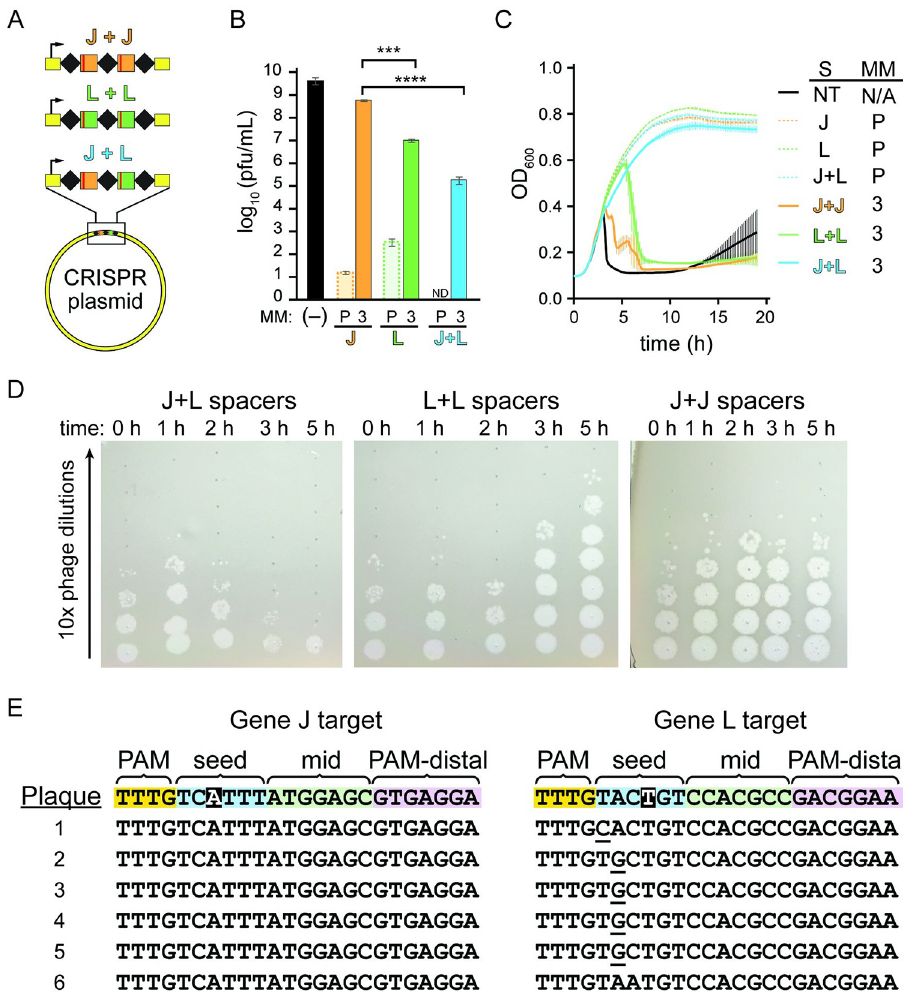
Fig 6. Multiple mismatched crRNAs provide more protection than individual mismatched crRNAs. (A) Schematic of experiment in which 2 crRNAs bearing mismatches at position 3 are expressed from a CRISPR plasmid. The CRISPRs either have 2 identical spacers targeting gene J (J+J) or gene L (L+L), or have 2 different spacers targeting gene J and L (J+L). (B) Number of plaques formed on lawns of bacteria expressing multiple mismatched crRNAs. Plaque assays were performed using bacteria containing a plasmid expressing FnCas12a along with different crRNA expression plasmids. Plasmid expressed either the perfect crRNA (P) or the position 3 mismatched crRNA (3). For the perfect crRNAs, plasmids expressed either 1 (gene J or gene L alone) or 2 (J+L) spacers. For the position 3 mismatched crRNAs, each crRNA expression plasmid contains 2 spacers: both targeting gene J both targeting gene L and 1 spacer targeting each of gene J and gene L (J+L). (-) indicates a negative control in which no crRNA was expressed. Plaque forming units (pfu) was calculated using the number of plaques on each plate and the volume of phage lysate added. The average of multiple replicates ( n = 2 to 4) is plotted with error bars representing standard deviation. Unpaired, two-tailed t tests were used to determine the statistical significance of each of the single spacer constructs compared to the double spacer construct, *** P � 0.001, **** P � 0.0001. See S2 Data for quantified data. (C) Growth curves using the same bacterial strains described in (A). Phage was added when the cells reached mid log phase at approximately 2 h after inoculation. The average of 3 replicates is plotted for each condition, with error bars representing standard deviation. See S2 Data for quantified data. (D) Spot assays used to measure the titer of phage over time in phage infection cultures. Spot assays were performed using 10-fold serial dilutions of phage harvested from cultures in (B) that infected bacterial strains with 2 mismatched spacers at different time points on lawns of CRISPR-inactive E . coli . (E) Sequences of both CRISPR targets in single phage plaques for phage harvested from E . coli cultures expressing a double spacer construct. The 2 crRNAs contained mismatches at positions highlighted in black. Target regions for the gene J and gene L target were sequenced for 6 individual plaques using Sanger sequencing. Target sequences are aligned to the WT sequence (top row) and mutations are underlined. See S12B Fig for chromatograms.